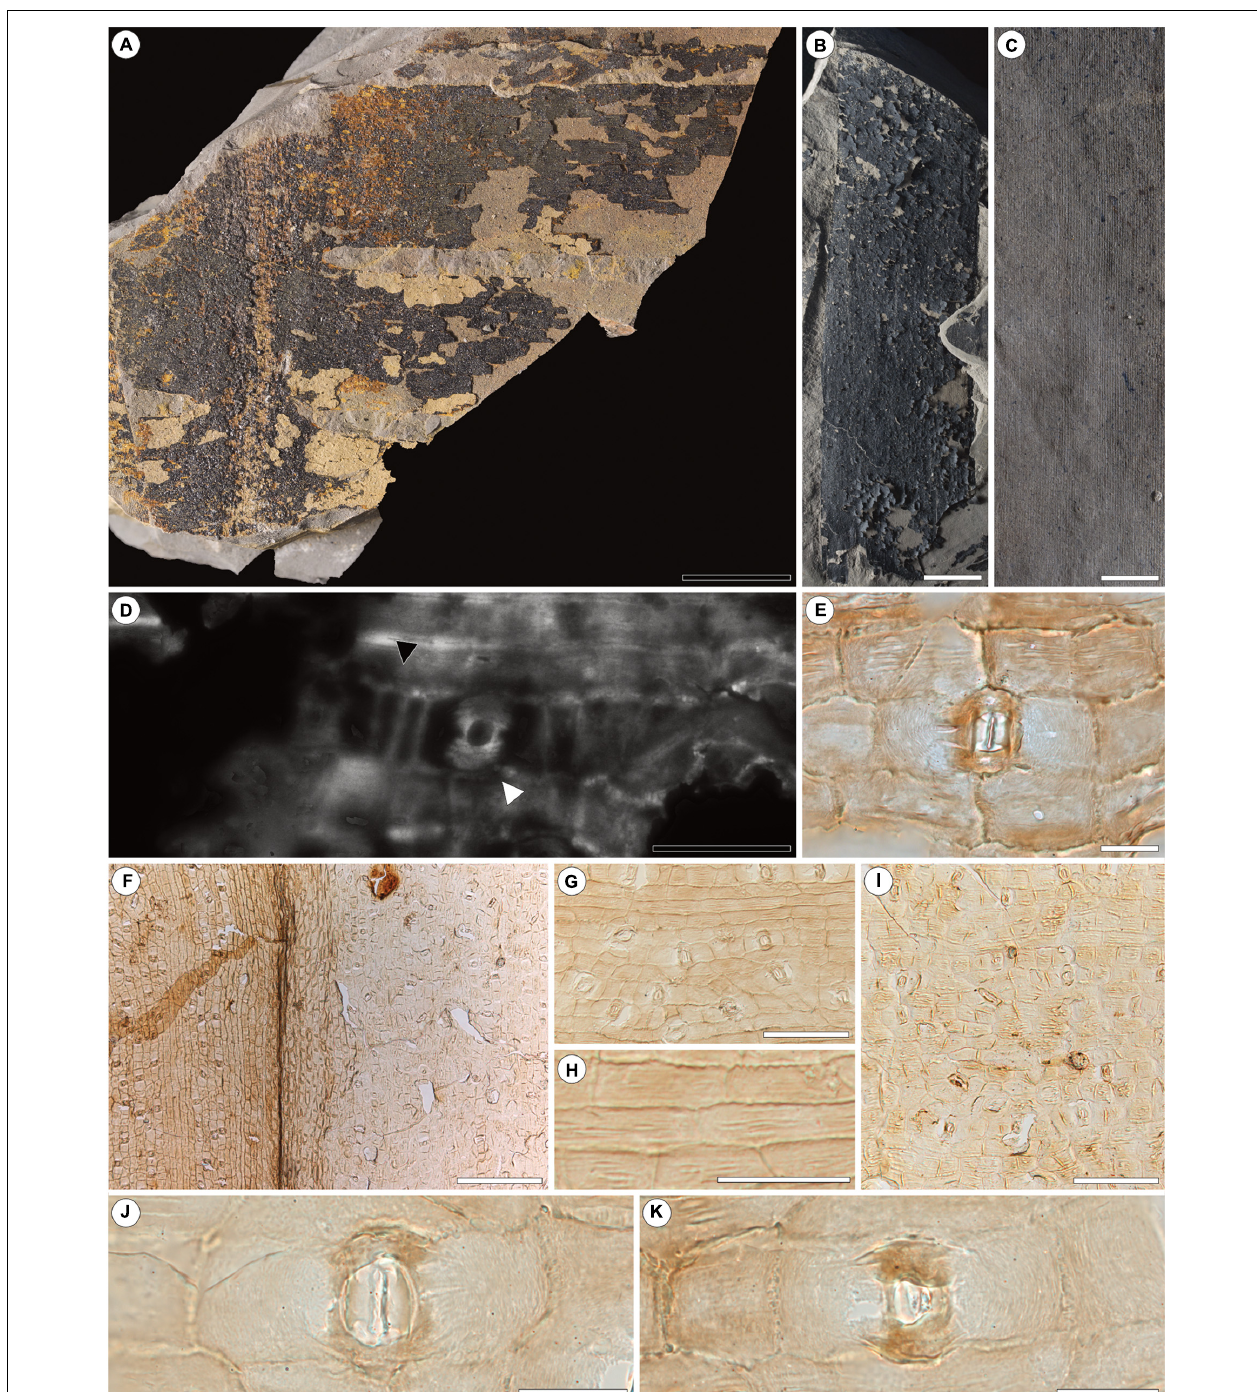
FIGURE 1 | Pterophyllum pottii Bomfleur et Kerp sp. nov. from the upper Permian of Jordan (A–K) . (A) Designated holotype of P. potti (JO15-5-115) showing the leaf morphology. (B,C) Isolated leaf fragment of P. pottii . (B) Leaf fragment with well-preserved cuticles loosely adhering to the matrix. (C) Counterpart of (B) showing the dense parallel venation. (D) Epifluorescence picture of a typical stoma of the holotype. Note the typical striate ledge of P. pottii (white arrow), palisade like subdivision (black arrow) and fragmentary preservation of the cuticle compared to (E–J) . (E) Typical stoma in transmitted light from (B) . (F) Lower (right) and upper (left) surface of P. pottii . Note the difference in stomatal density. (G) Upper leaf surface of P. pottii . (H) Detail of (G) showing the distinct striation on the periclinal walls. (H) Detail of (G) showing the longitudinal striae on periclinal walls and slightly undulating anticlinal walls. (I) Lower leaf surface of P. pottii . Note the difference in epidermal cell sizes. (J,K) Enlarged stomata of the lower leaf surface. Note the strongly thickened, overhanging polar ledges. Scale bars for (A,B) = 1 cm; (C) = 5 mm; (D) = 50 µ m; (E) = 20 µ m; (F) 200 µ m; (G) = 100 µ m; (H) = 50 µ m; (I) = 100 µ m; (J,K) = 20 µ m.